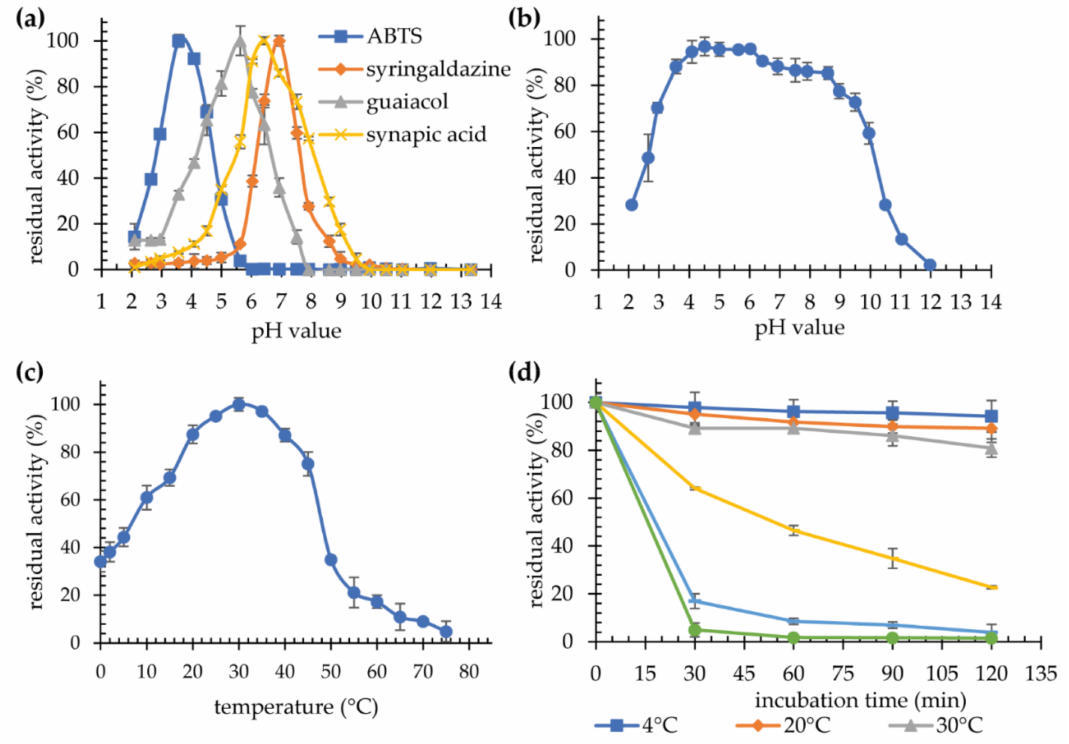
Figure 5. Characterization of purified recombinant laccase KbLcc1; ( a ) optimal pH in reaction with different substrates; ( b ) pH-stability after 24-h incubation at 4 ◦ C (with ABTS used as a substrate); ( c ) optimal temperature in reaction with ABTS as a substrate; ( d ) thermostability at 4 ◦ C, 20 ◦ C, 30 ◦ C, 40 ◦ C, 45 ◦ C and 50 ◦ C; pH-stability and thermostability obtained with ABTS as a reaction